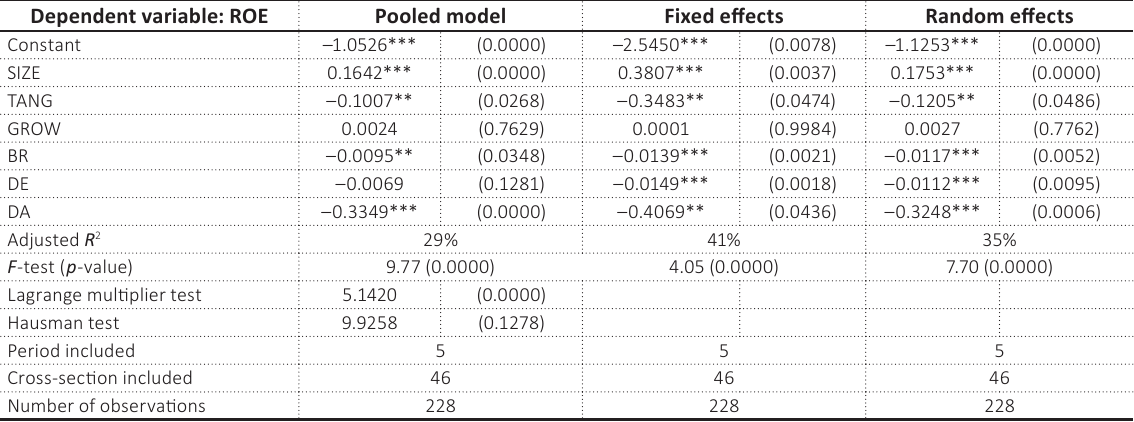
Table 6. Ordinary least squares regression results Dependent variable: